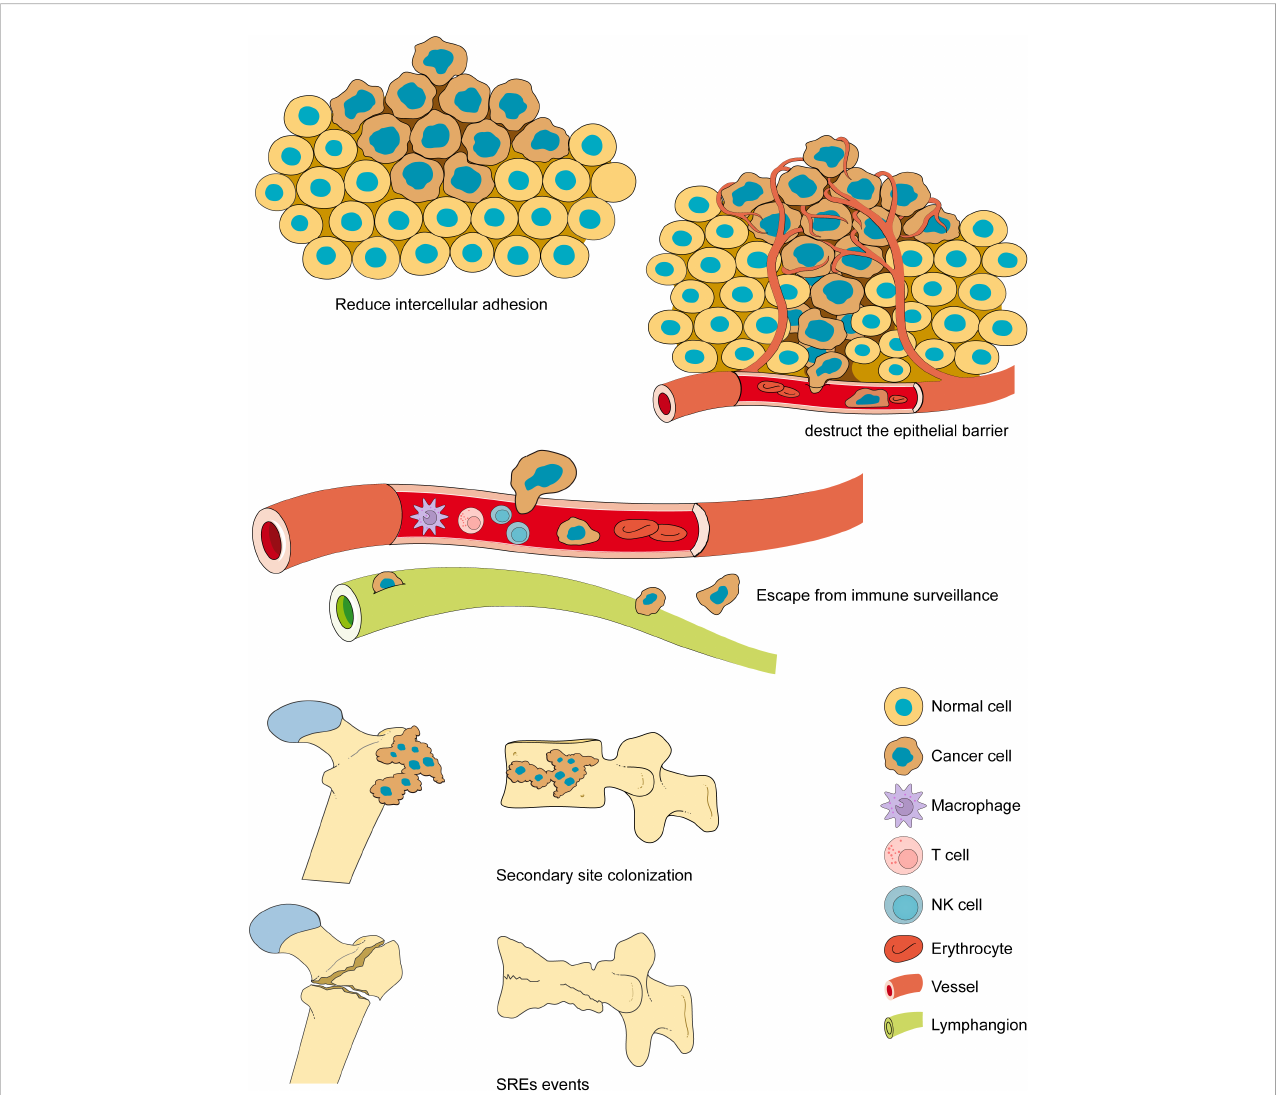
FIGURE 2 The bone metastasis. The bone metastasis is a complex biological process. Tumor cells metastasizing from the primary site to other tissues and organs generally undergo the steps of reducing intercellular adhesion, overcoming barriers, escaping from immunity, colonizing secondary sites, proliferation and growth and lead to SREs. The bone metastases often lead to serious complications, including fractures, nerve compression, and severe pain, resulting in loss of mobility, a signi fi cant increase in medical costs, and a signi fi cant reduction in quality of life and